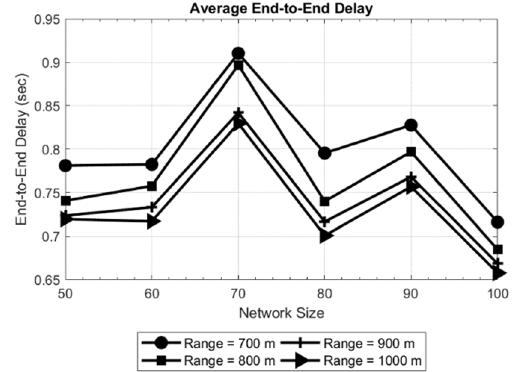
Figure 6. End-to-end delay for longest path in network of 200 × 200 × 200 m.